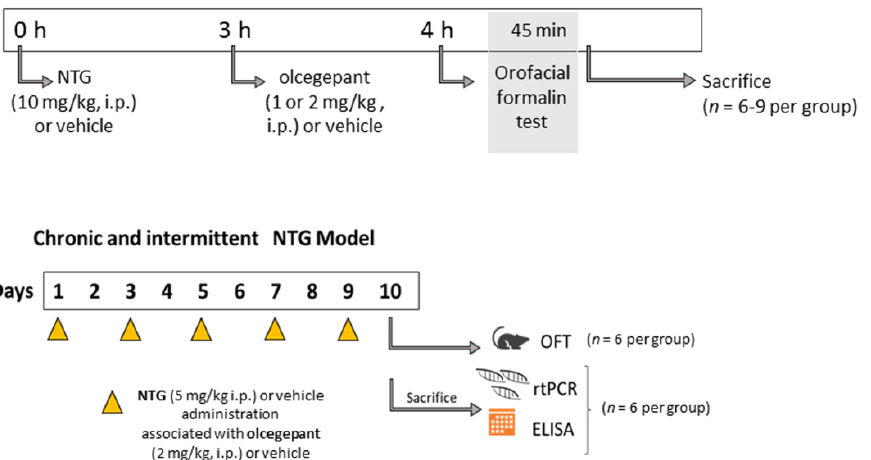
Figure 1. Experimental design of the acute and chronic models with specific procedures. Acute migraine model: after treatments, the animals underwent the orofacial formalin test; at the end of the behavioral test, all animals were sacrificed. Chronic migraine model: after treatments, the animals were divided into two different experimental sets. In the first set, the animals underwent the orofacial formalin test and then they were sacrificed. Within the second set, after sacrifice, the samples were collected to be used for rt-PCR and ELISA analysis. ELISA: enzyme-linked immunosorbent assay; n : number of animals per group; NTG: nitroglycerin; OFT: orofacial formalin test; rt-PCR: real time polymerase chain